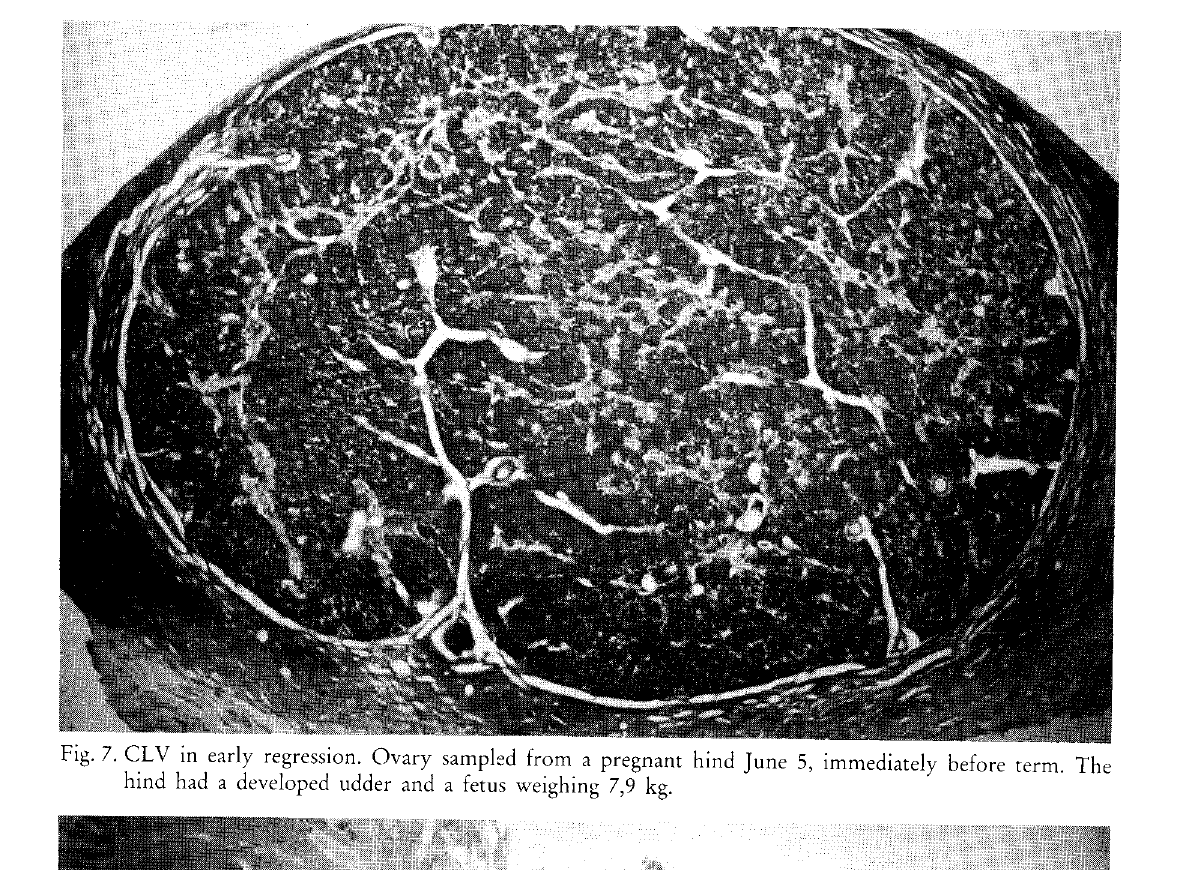
Fig. 7. C LV in early regression. Ovary sampled from a pregnant hind June 5, immediately before term. The hind had a developed udder and a fetus weighing 7,9 kg.